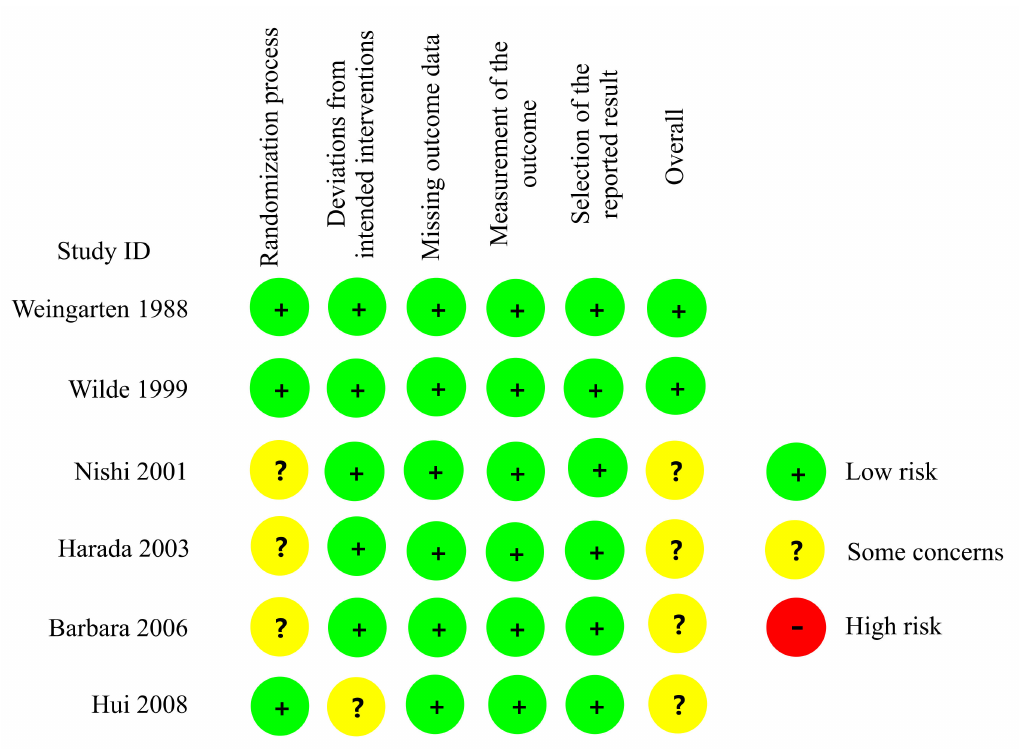
Figure 1. Flow diagram of study selection.